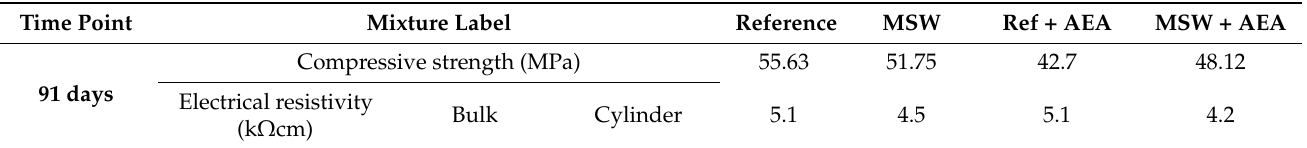
Table 5. Laboratory test results at 91 days.